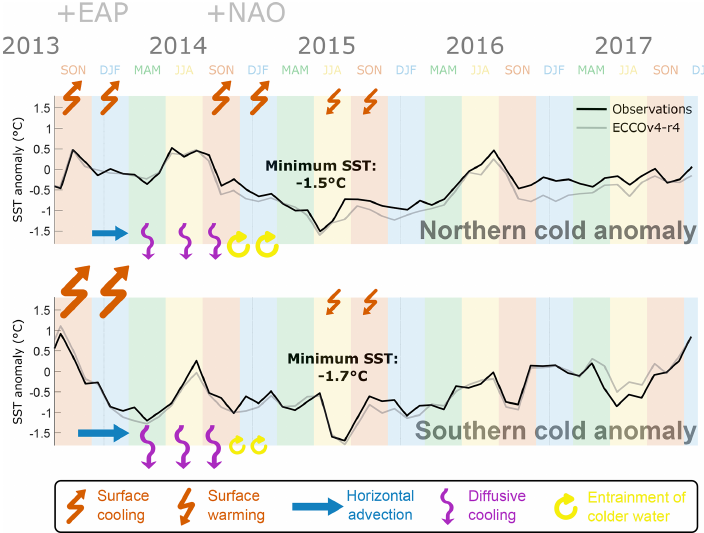
Figure 11. Schematic illustrating the processes involved in the evolution of the 2015 North Atlantic cold anomaly. The black line shows the SST anomaly in the HadISST1 observations averaged over the north (top) and south (bottom) of the cold blob region, with the 1992–2017 climatology removed, while the grey line shows the anomalies in ECCOv4-r4, averaged over the same region. The arrows show anomalies in the various processes driving the cold anomaly, with larger arrows representing the more important